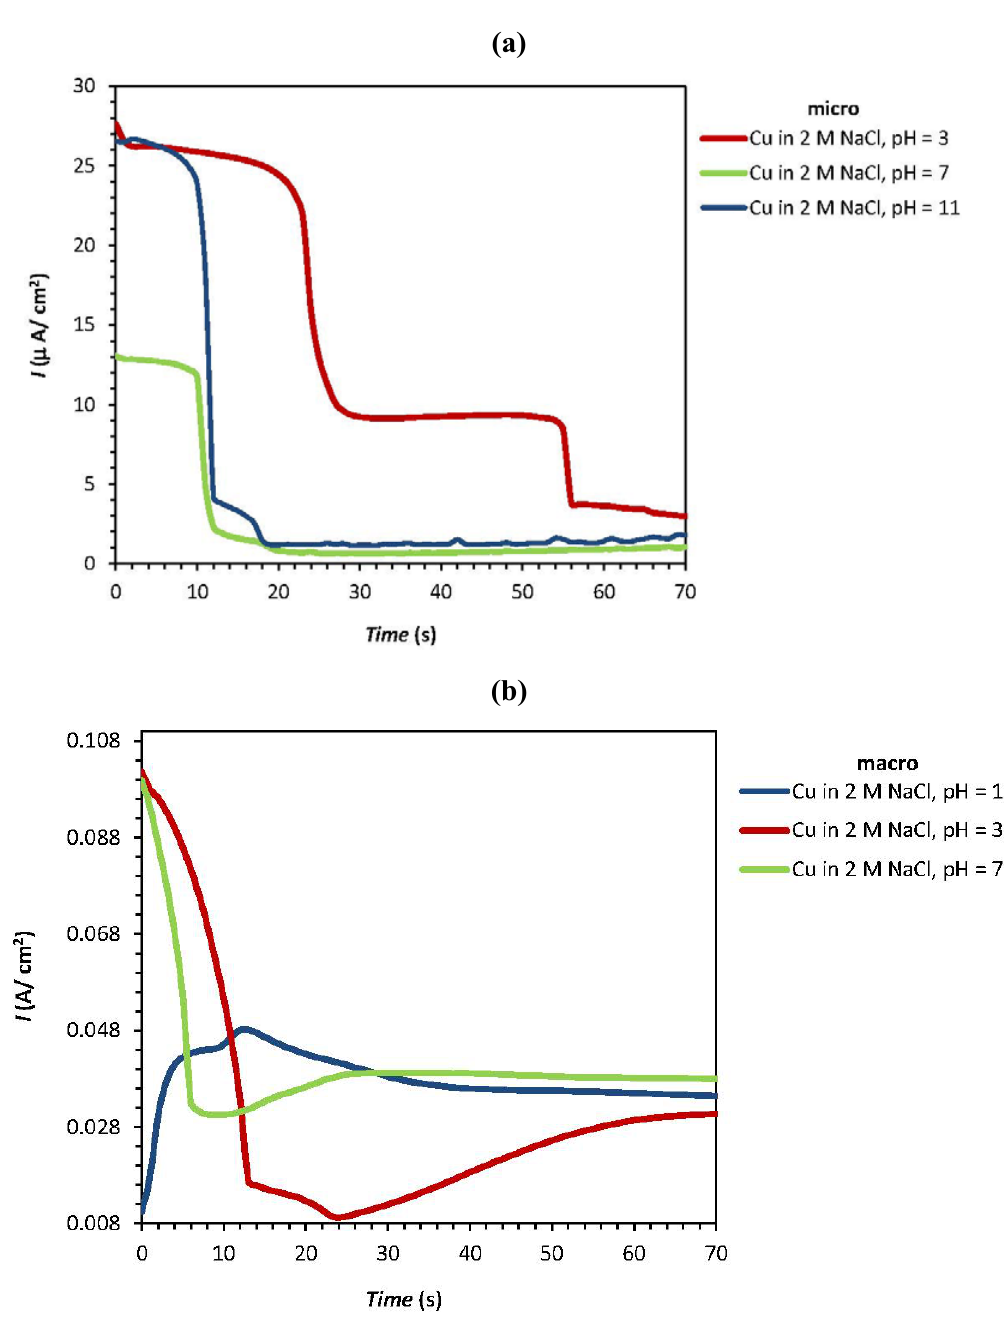
Figure 3. Potentiostatic polarization curves of pure copper for various ( a , b ) pH values and ( c , d ) NaCl concentrations at the micro and macro scale. The tip diameter of the used microcapillary is ~100 μ